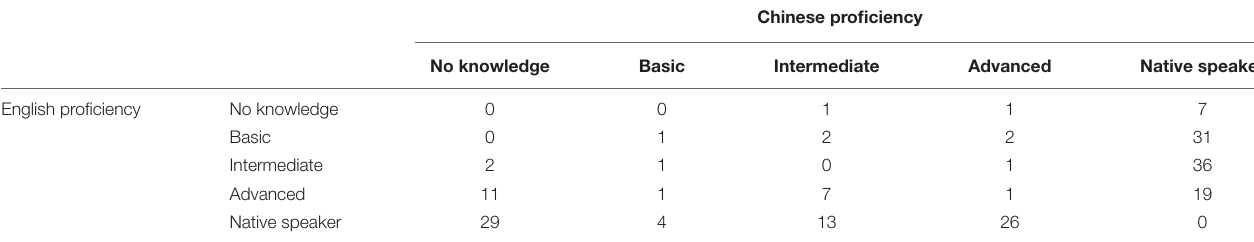
TABLE 3 | Language proficiency distribution.